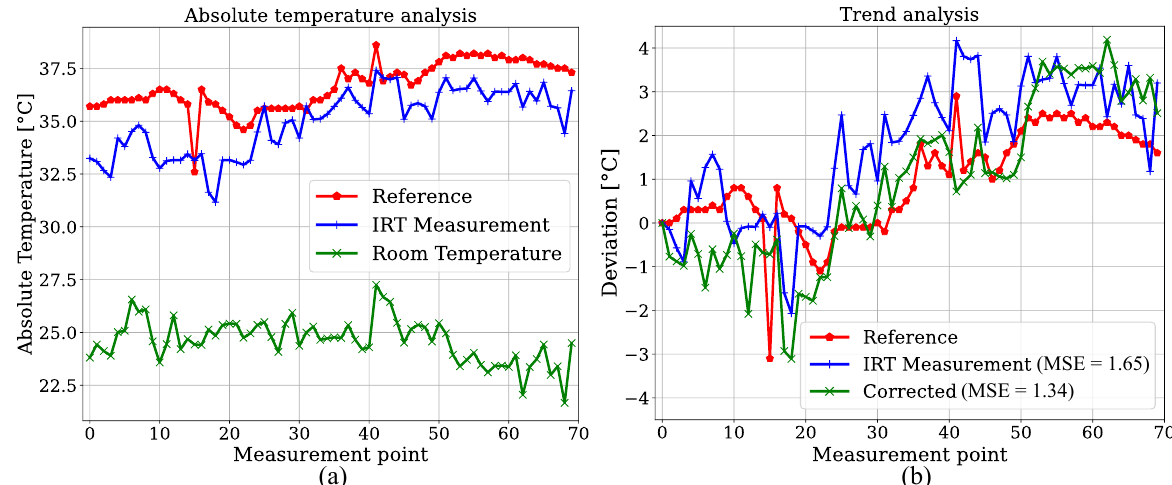
Figure 10. ( a ) Absolute temperature analysis for reference measurements in bladder. ( b ) Relative deviations for room temperature correction.